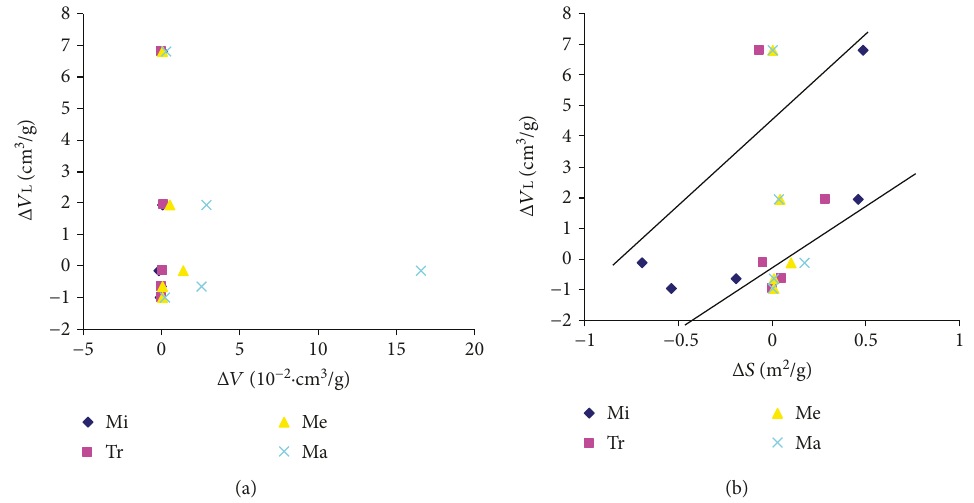
Δ V and Δ S : (a) Δ V Figure 8: Δ V L versus